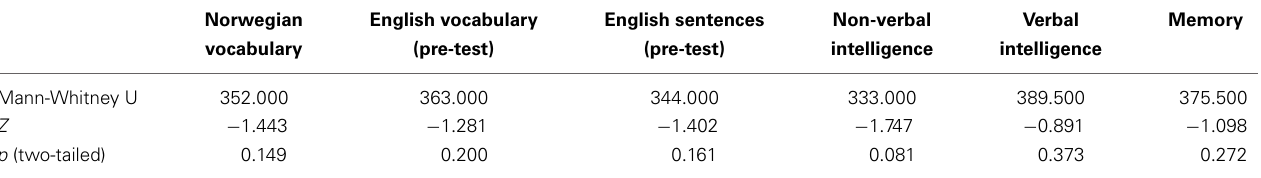
Table 3 | Mann-Whitney U , Z, and p for between-groups comparison of vocabulary, verbal and non-verbal intelligence and memory in the bilingually-based and the native language-based